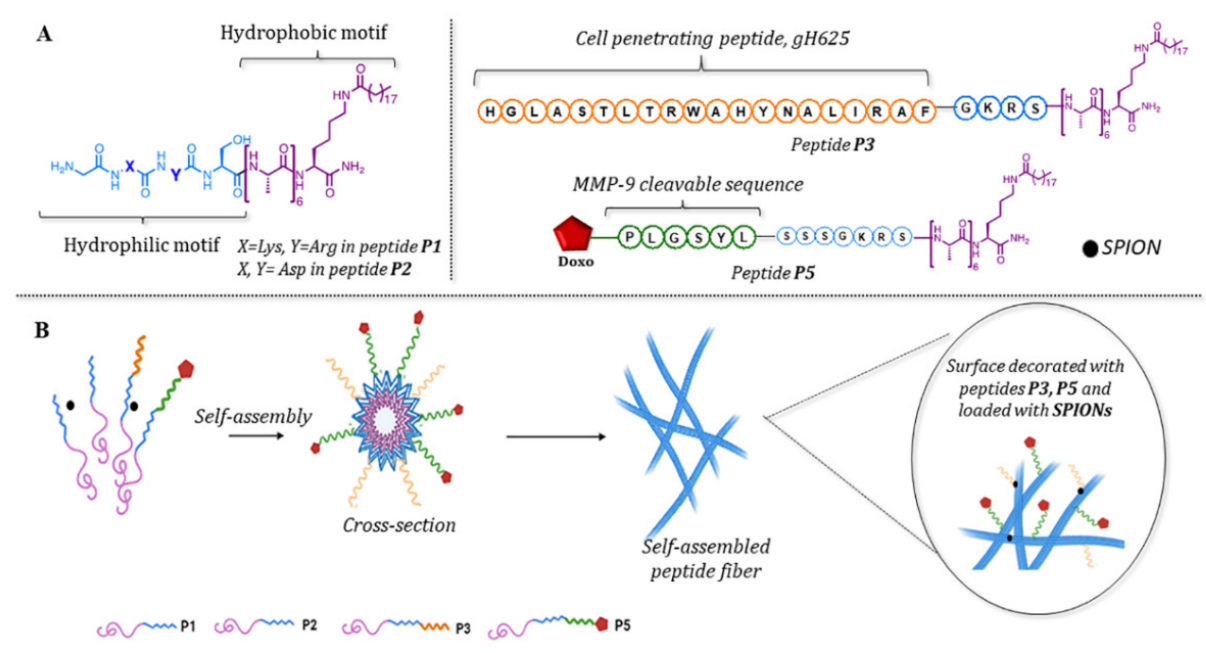
Figure 2. Schematic representation of peptides involved in nanofiber composition ( A ) and the potential self-assembly process leading to the organization in nanofibers ( B ). This figure was created with BioRender.com (accessed on 1 January 2022).